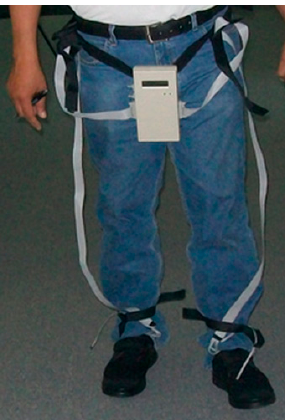
Figure 8. System placed on one of the test subjects.